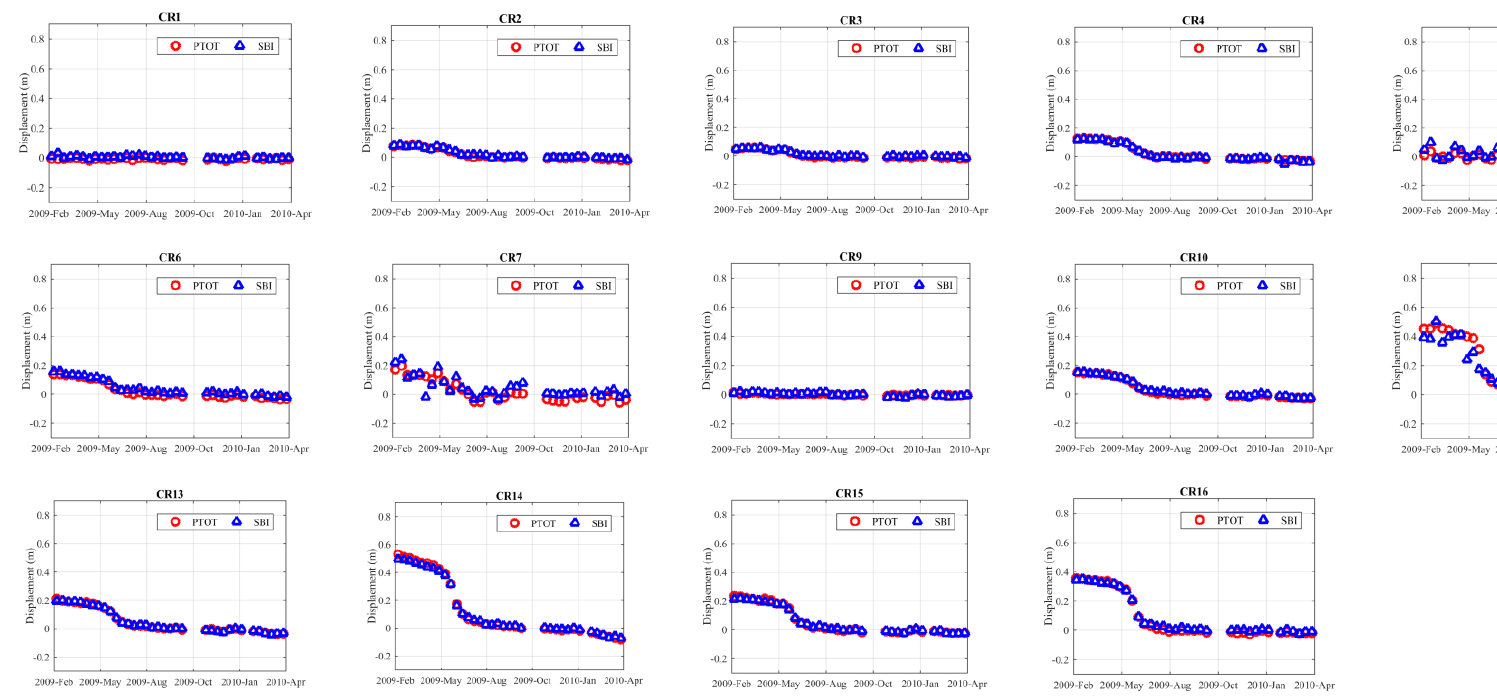
Figure 6. Comparison of time series displacements of CRs on Shuping landslide in range direction obtained by PTOT and SBI method.